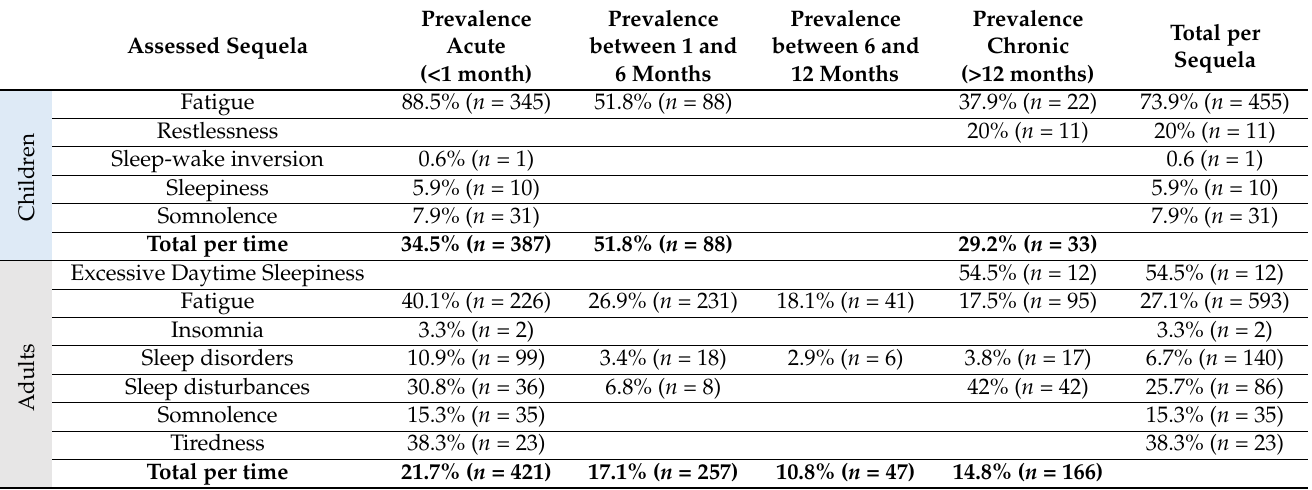
Table A2. Overview of the number of patients reporting each sequela per timepoint based on the criteria used in the